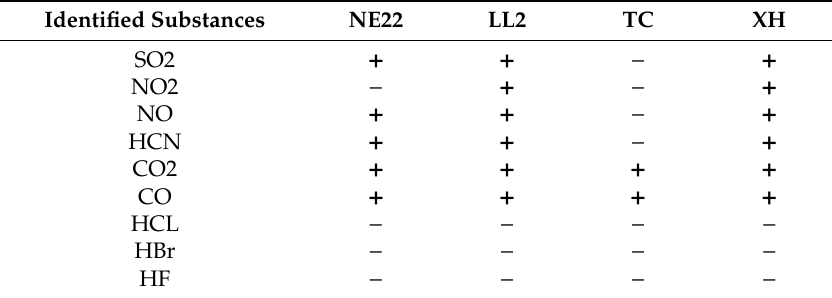
Figure 4. Fourier-transform infrared spectroscopy (FT-IR) spectra from the thermal decomposition and combustion of belts: ( a ) NE22, ( b ) LL2, ( c ) TC, and ( d ) XH. Table 4. Comparison of identified substances in fumes after performing tests in accordance with PN-B-02855